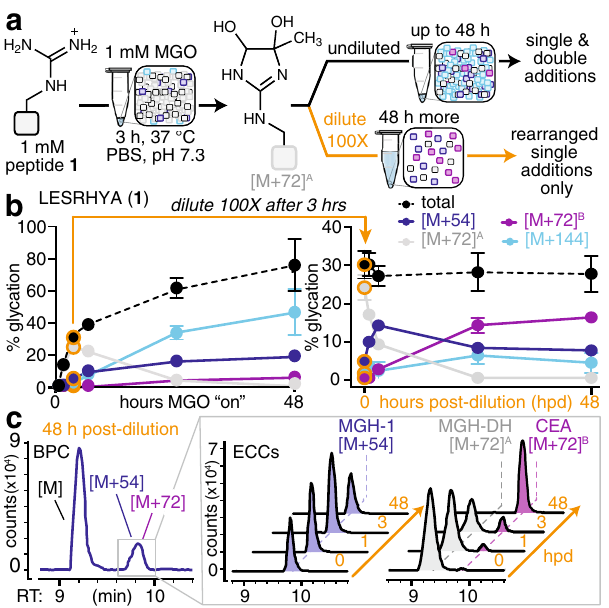
Fig. 4 MGH-1 is mechanistically related to MGH-DH and CEA. a To focus on the formation of single MGO additions, peptides were treated using our standard reaction conditions for 3 h and then diluted 100× in the same buffer. This adapted protocol slows the formation of AGEs that require a second MGO equivalent, but allows intramolecular reactions and/or rearrangements to proceed without competition. b Time course of glycation for peptide 1 treated with MGO for up to 48 h undiluted (left) or up to 48 h post-dilution (hpd) (right). After 3 h of treatment with equimolar (1 mM) MGO, the reaction was diluted 100× in the identical reaction buffer (orange arrows and data points). Time course data are plotted as mean ± standard deviation for each mass adduct. Legend: blue, [M + 54]; gray, [M + 72] A ; purple, [M + 72] B ; cyan, [M + 144]. Levels of [M + 126] remained at 5% or less throughout the entire time course and are not shown. c Representative base peak chromatogram (BPC) for peptide 1 at 48 h post- dilution (hpd). Extracted compound chromatograms (ECCs) of the [M + 54] (left) and [M + 72] (right) adducts observed from 0 – 48 h post-dilution (hpd). For experiments that con fi rm the identities of these adducts, please see Supplementary Figs. 15 – 18. Source data are provided as a Source Data fi le.